Question: Condense the content of this figure into a single sentence.
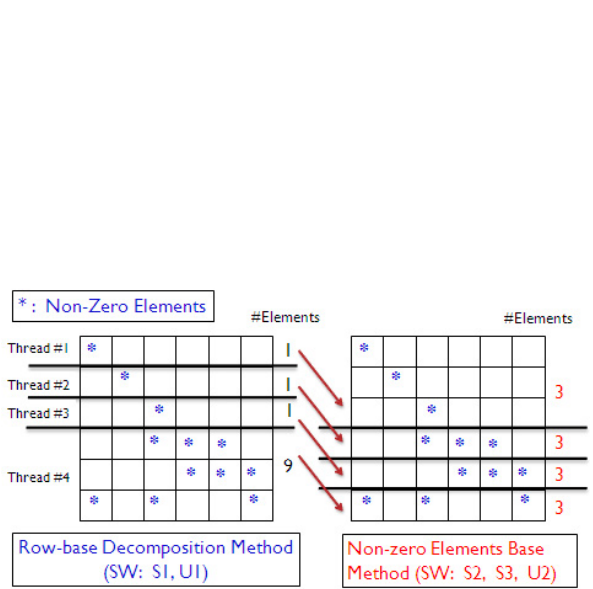
Answer: Example matrix causing heavy unbalanced  computations due to the number of non-zero elements. This  also shows the effect of parallelization for non-zero elements.